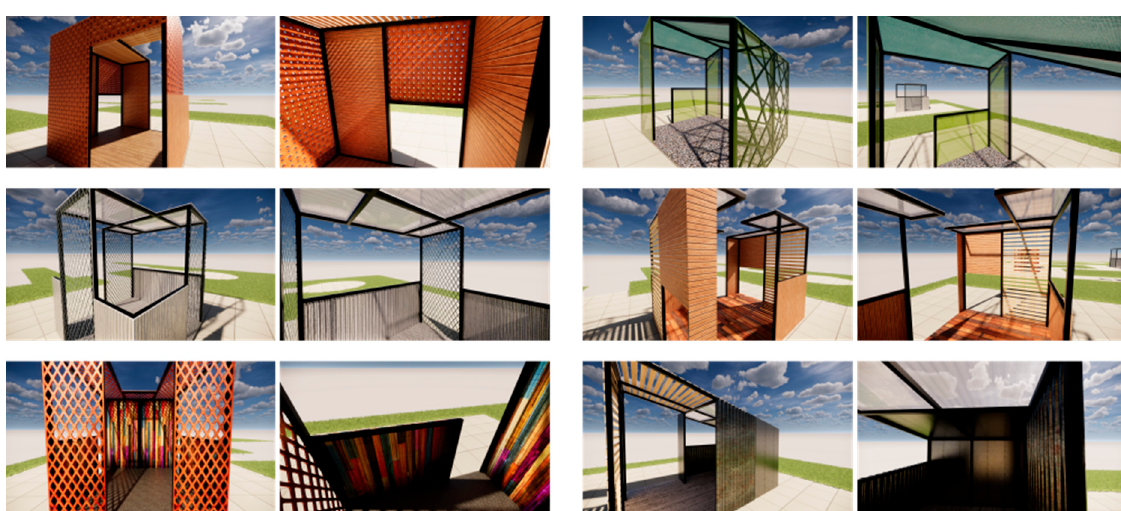
Appl. Sci. 2021 , 11 , x FOR PEER REVIEW 14 of 23 Figure 11. Tour of architectural spaces. Figure 11. Tour of architectural spaces.